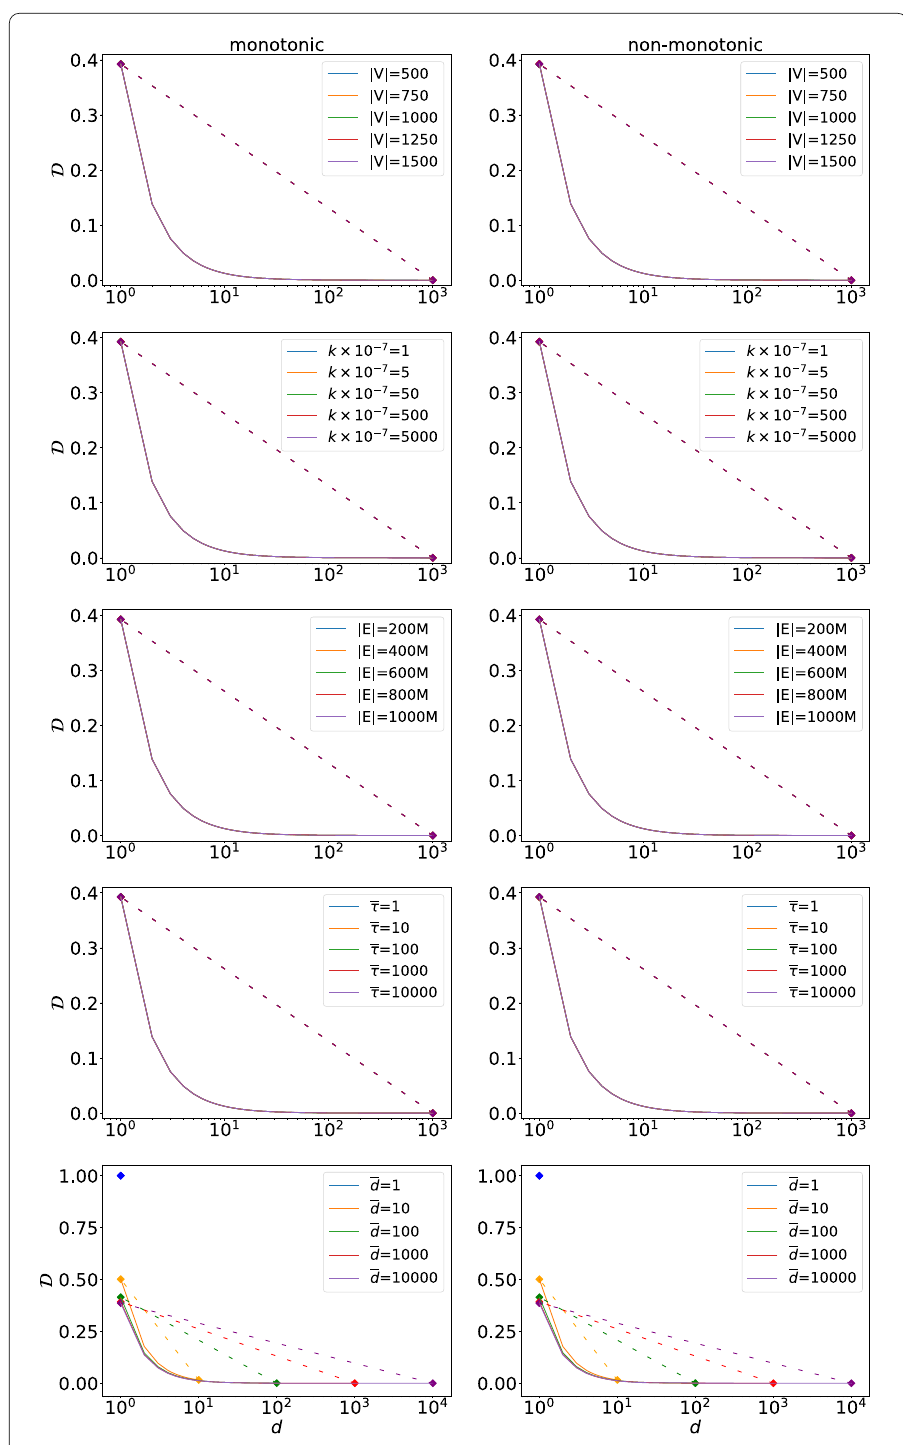
Figure 12 The duration distribution in various networks. We note that higher d tends to pull down the durations’ aggregation on small